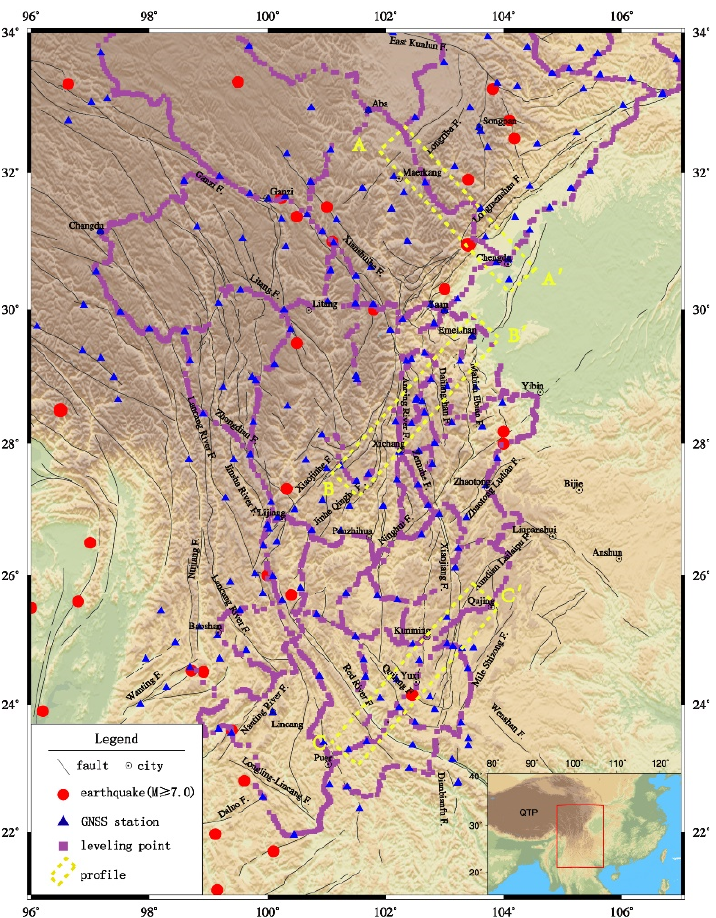
Figure 1. The tectonic setting of the Sichuan–Yunnan region (SYR). Triangles and squares denote GNSS stations and leveling points, respectively. Red dots denote the M ≥ 7.0 earthquakes occurred in this region since 1900. Profiles AA ′ , BB ′ and CC ′ will be discussed in Section 3.1. Inset shows the location of the study area in China.